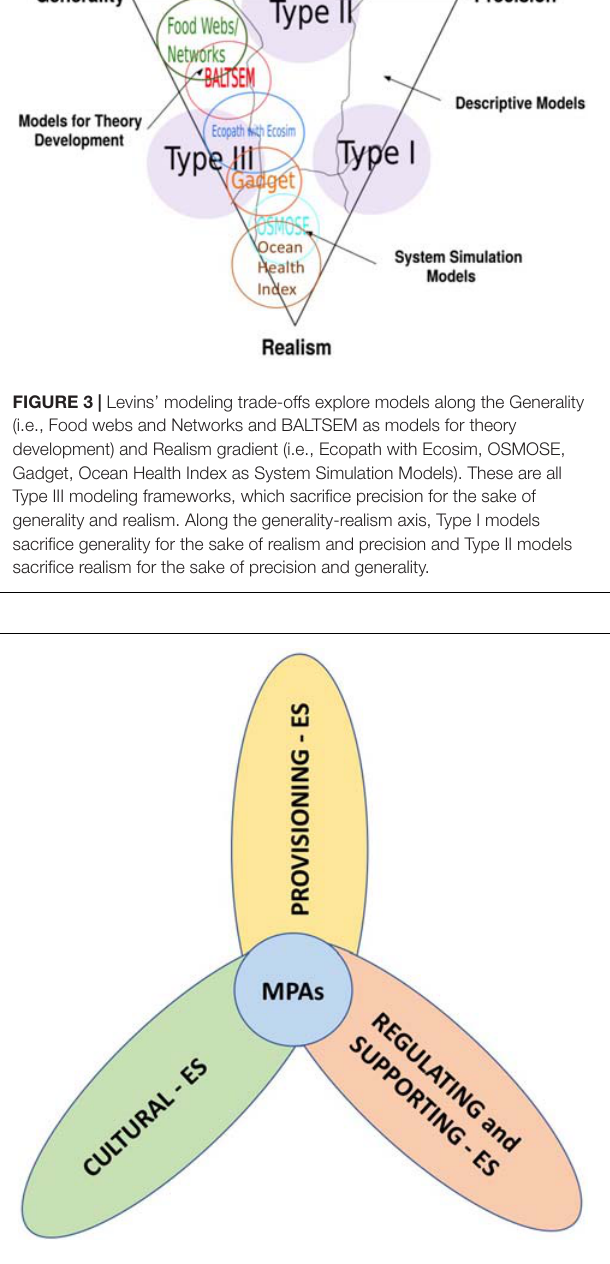
and Ecospace (Steenbeek et al., 2013) or Atlantis (Audzijonyte et al., 2019) are valuable tools to explore such dynamics.